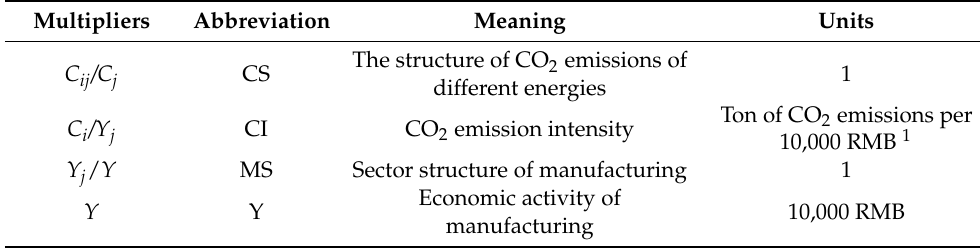
Table 3. Definitions of the